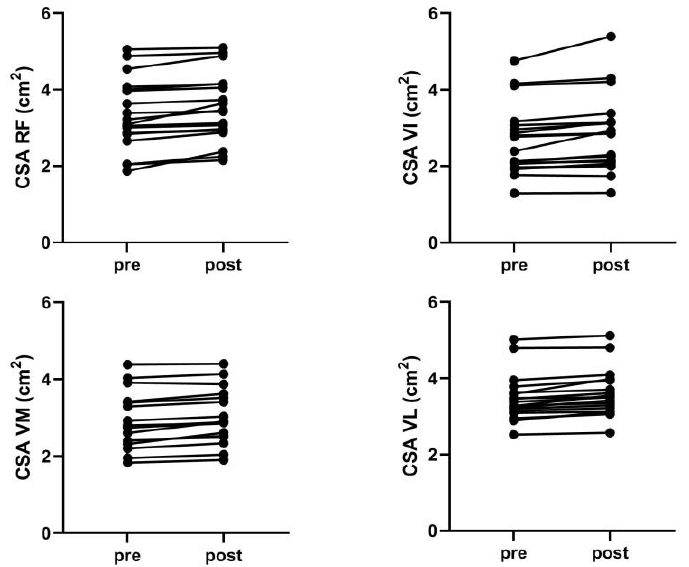
Figure 2. Individual pre-to-post changes in cross-sectional area (CSA) of rectus femoris (RF), vastus intermedius (VI), vastus medialis (VM), and vastus lateralis (VL). Regression analysis identified ΔVL CSA as the only significant predictor of Δ1RM (r = 0.758, p < 0.001), with VL hypertrophy explaining approximately 55% (adj. R2 = 0.548, p < 0.001) of the variance in strength gain (Figure 3). On the other hand, the ΔCSA of RF (r = 0.006, p = 0.981), VI (r = 0.465, p = 0.052), and VM (r = 0.227, p = 0.365) were not signifi- cantly related to the Δ1RM. Figure 3. Relationship between relative changes ( ∆) in squat strength (1RM) and cross -sectional area (CSA) of vastus lateralis muscle. 4. Discussion This study investigated the effectiveness of squat RT in promoting quadriceps hy- pertrophy at the individual level and also examined whether changes in the CSA of QF muscles were related to gains in squat strength. The main findings revealed that: (i) squat RT significantly increased the CSA of four knee extensors, with no differences between them, and (ii) the gain in squat strength was only related to the hypertrophy of VL muscle. Contrary to our hypothesis, the present results demonstrate that the parallel squat is an effective training tool to induce a significant hypertrophic response of all QF muscles